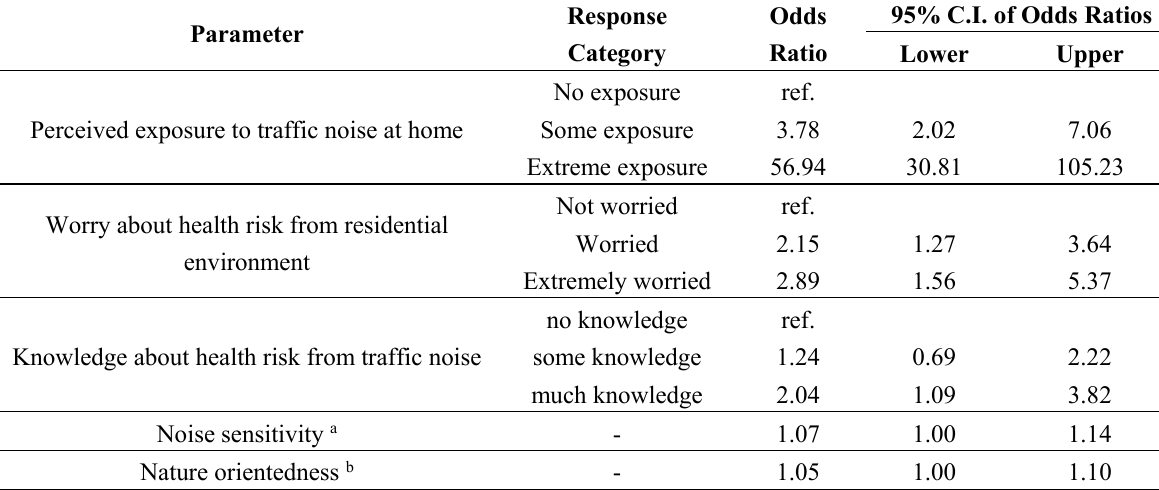
Table 4. Determinants of high to extreme noise